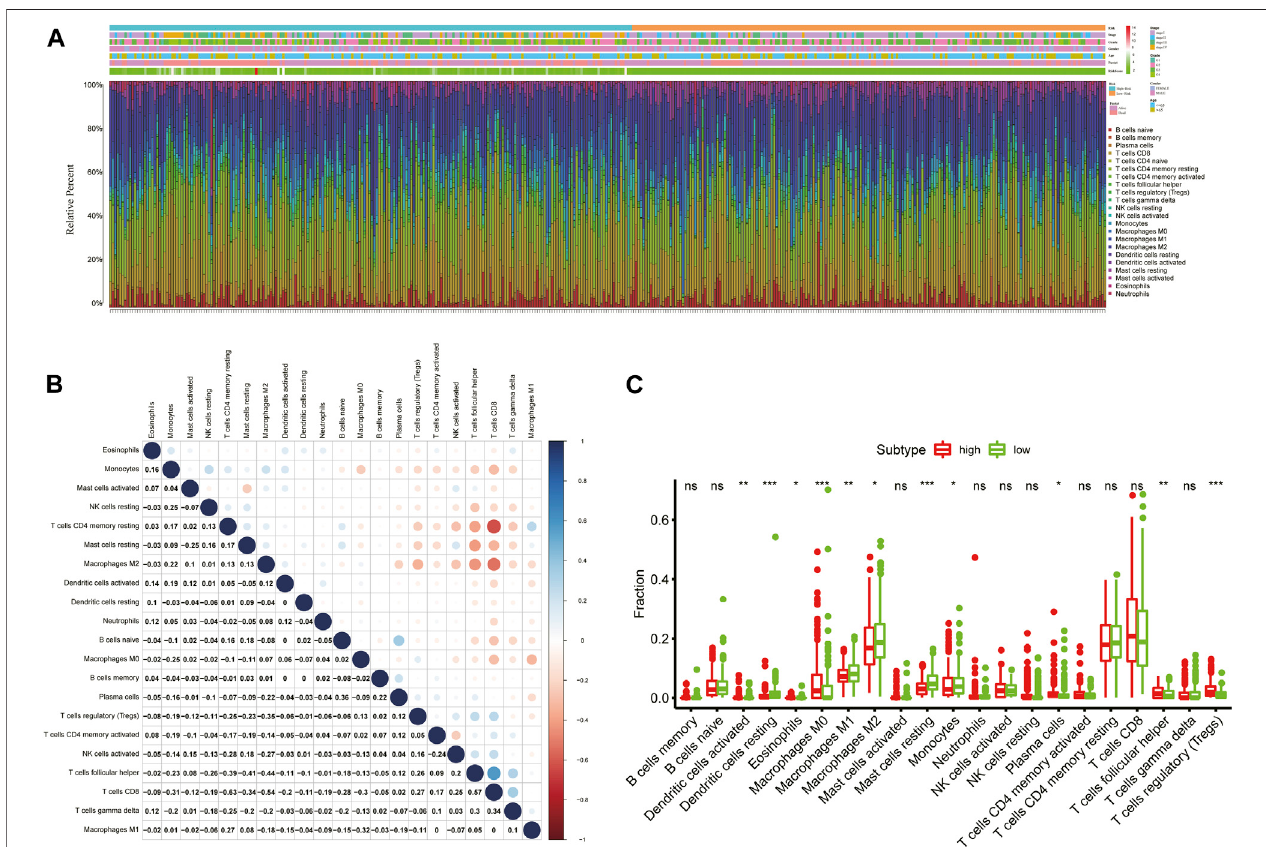
FIGURE 9 | Immune in fi ltration landscape of KIRC patients in low- and high-risk groups. (A) Relative percentage of 22 immune cells in low- and high-risk KIRC patients; (B) Correlation analyses between 22 types of immune cells; (C) Fractions of 22 immune cells between low- and high-risk groups. * p < 0.05; ** p < 0.01; *** p <